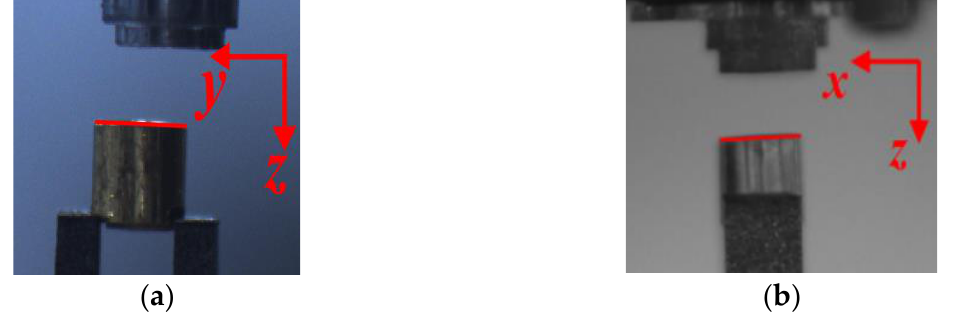
Figure 16. Size calibration of CCD. ( a ) Draw lines on the hohlraum to mark its front size; ( b ) Draw a line on the hohlraum to mark its left side size.